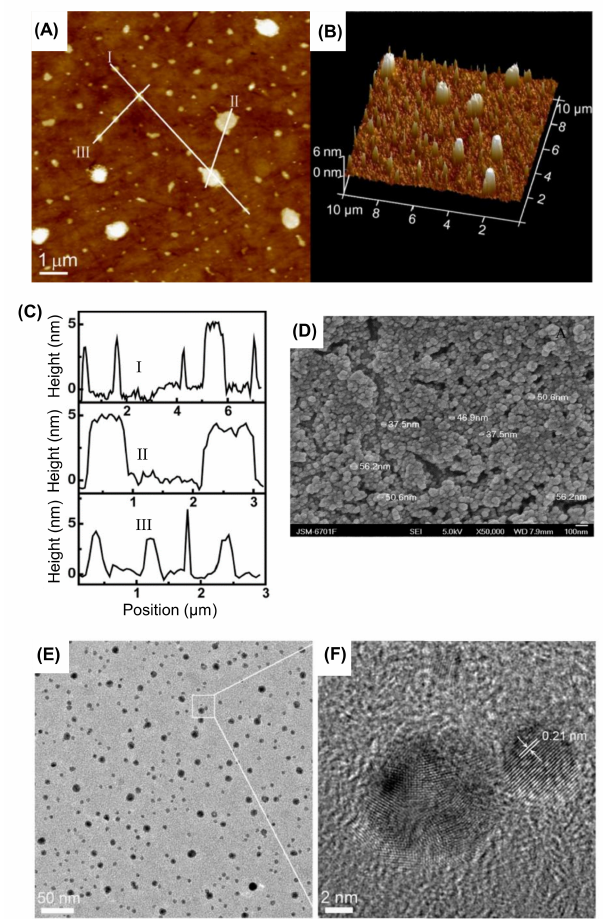
Figure 4. Illustrations of various microscopic images for the characterization of CDs. ( A ) 2D topographical AFM image. Reproduced from [156], with permission from Elsevier, 2014. ( B ) 3D topo- graphical AFM image. Reproduced from [156], with permission from Elsevier, 2014. ( C ) The height profiles of lines I, II, and III that are mentioned in (A). Reproduced from [156], with permission from Elsevier, 2014. ( D ) SEM image. Reproduced from [157], with permission from Elsevier, 2014. ( E ) TEM image [158]. ( F ) HRTEM image